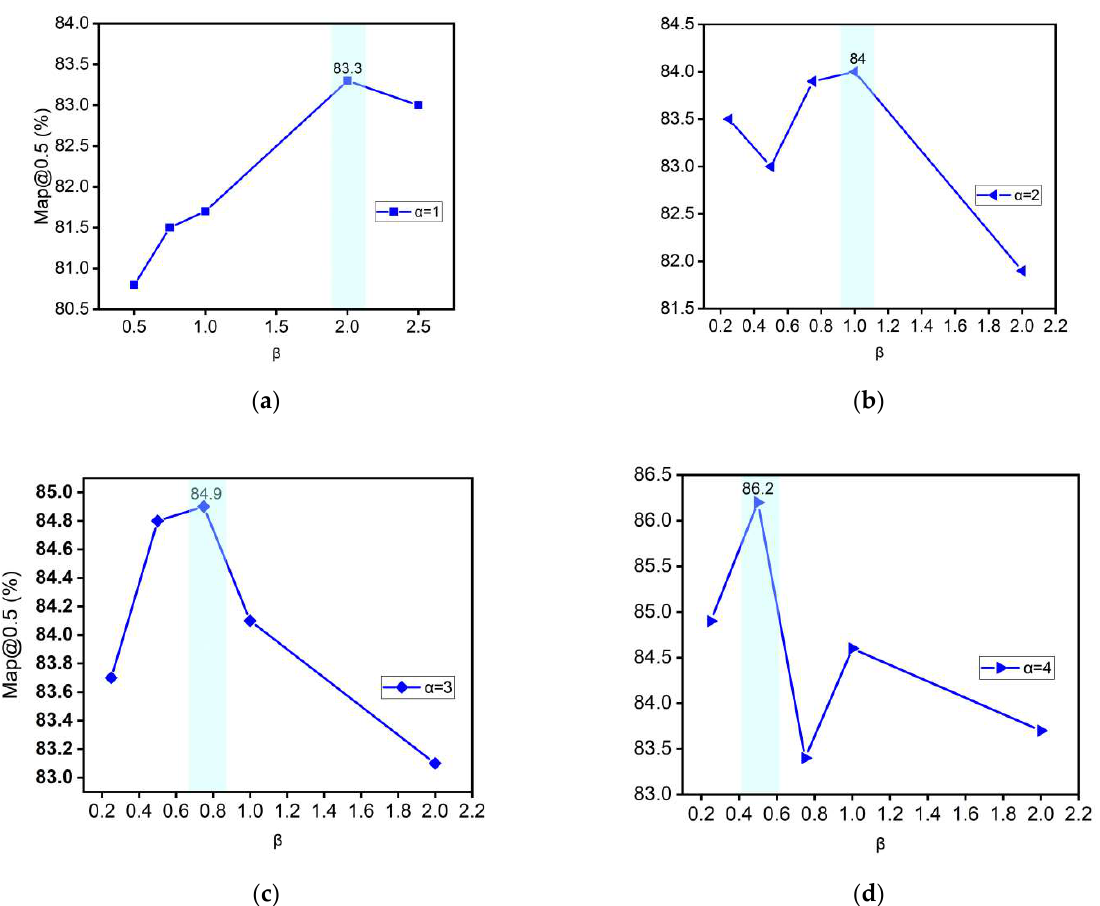
Figure 8. ( a – d ) shows the adjustment of the attention layer using different depth ( α ) and scaling ( β ). Find the effect of scaling β on accuracy at different α with β = 1 as the baseline, respectively, for the current α.